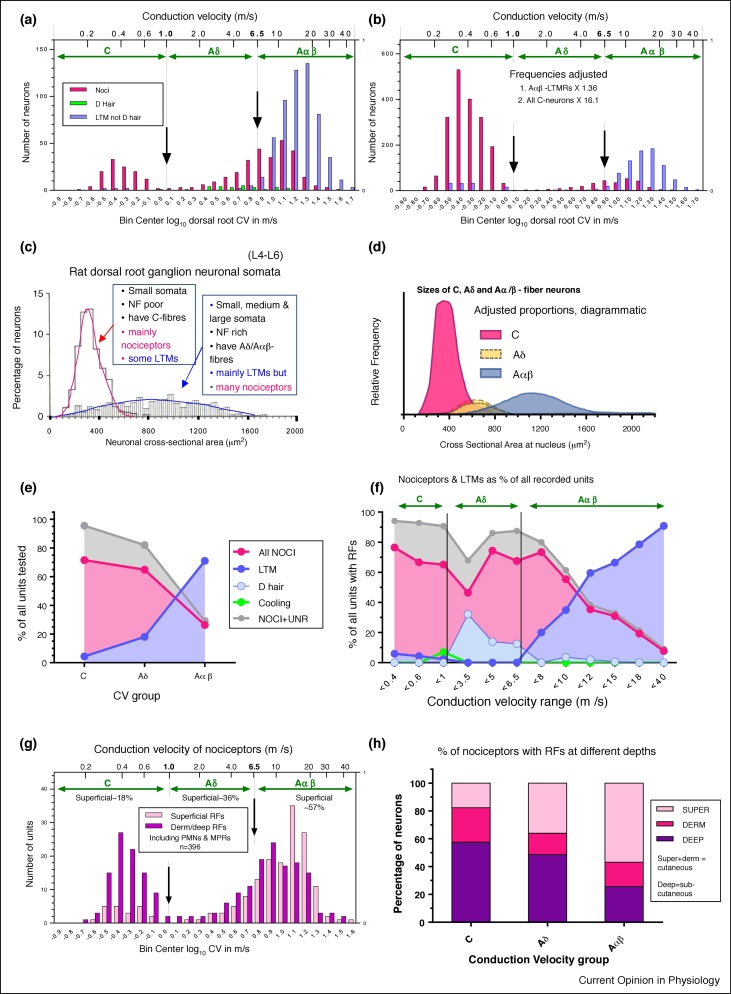
(a) CVs of nociceptive and LTMR L4/L5 DRG neurons. Because of the difficulty of showing distributions of C-fiber and A-fiber CVs on the same graph, log10 CVs were plotted with bin widths of 0.1 log units; unlogged CVs shown at top of graph. All nociceptors are red; and C-LTMRs and Aαβ-LTMRs (low threshold mechanoreceptors) are blue, and Aδ-LTMRs (D hair units) are green for. Vertical lines and arrows show boundaries between CV groups, determined by compound action potential recordings by X Fang 2002 [17], and confirmed by CV distributions of Aαβ-LTMRs and Aδ-LTMRs (a and b).(b) Data in (a) adjusted to counter bias during recordings. Adjustments (Table 1 legend) to compensate for rejection of Aαβ-LTMRs during recording, and to adjust for the underestimated C-neuron population to make up 70% of the total [30], using values shown on graph and Table 1.(c) The two overlapping size distribution of NF-rich and NF-poor rat L4-L6 DRG neurons: Size = area = cross-sectional area measured at nuclear, mid-soma, level. NF-poor neurons (open histogram) have C-fibers [21,22]. This population includes mainly nociceptors and unidentified units, including silent-nociceptors, with few LTMRs in these DRGs that project mainly to distal hindlimb. The neurofilament-rich (NF-rich, striped histogram) neurons have A-fibers and are mainly LTMRs, with some nociceptors [21,22].(d) Cartoon of area distributions of C, Aδ- and Aαβ-neuronal somata. Means and ranges for each population from previously published plots [14,21,26], but amplitude of the C-neuron population (red) is adjusted upwards (adjustment 2, see Table 1 legend) to compensate for underrecording of C-neurons. The Aδ-neurons have medium-sized somata that overlap with C-neurons and Aα/β-neurons. It is not known whether the Aδ-neurons are underrepresented (indicated by two dotted outlines).(e) Percentages of C-, Aδ- and Aα/β-neurons that were nociceptive, LTM or unidentified/silent. Only Aαβ-percentages were adjusted (Table 1 legend). No C-neuron adjustment needed as comparisons are within CV groups.(f) Similar to E but subdivided into smaller CV groups to show the changes in these percentages.(g) Percentages of nociceptors with superficial RFs. CVs (log plot) of nociceptors with receptive fields (RFs) that are superficial (red), or in dermal or deeper tissues (pink). The percentage with superficial RFs is low (∼18%) in C-nociceptors, higher in Aδ-nociceptors and increases with CV in Aβ-nociceptors to dominate in the 12–20 m/s range.(h) Summary graph. Percentages of C, through Aδ and Aαβ-nociceptors with superficial, dermal or deep RFs are shown.